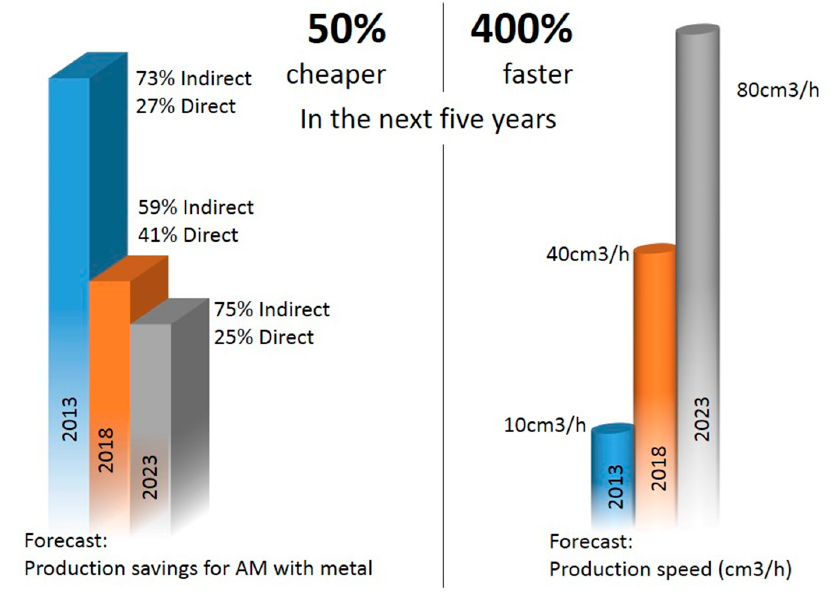
Figure 12. The saving of production in cost and speed, reproduced from Reference [18].